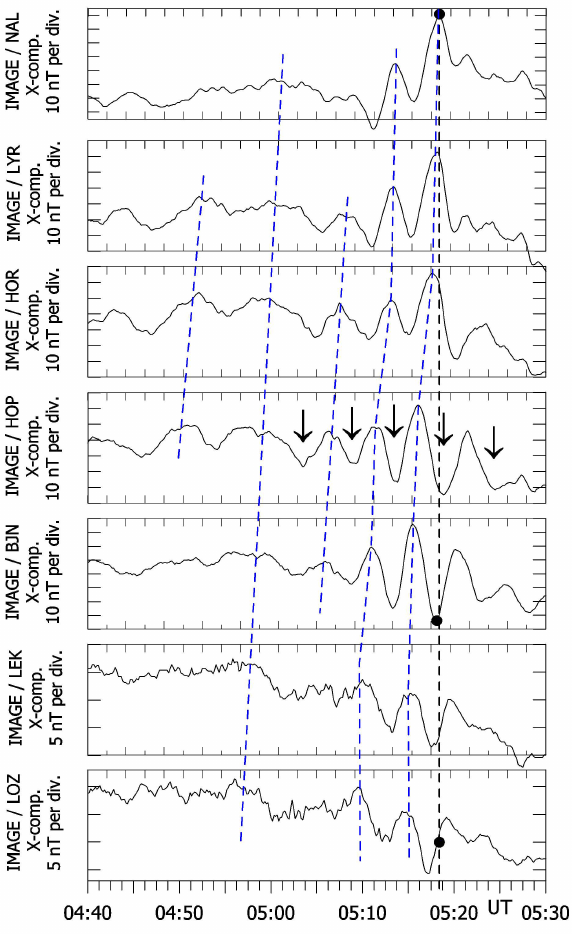
Fig. 11. Same format as in Fig. 3 for the event of day 214, 2001. In particular, we pay attention to the phase changes observed at ∼ 05:17